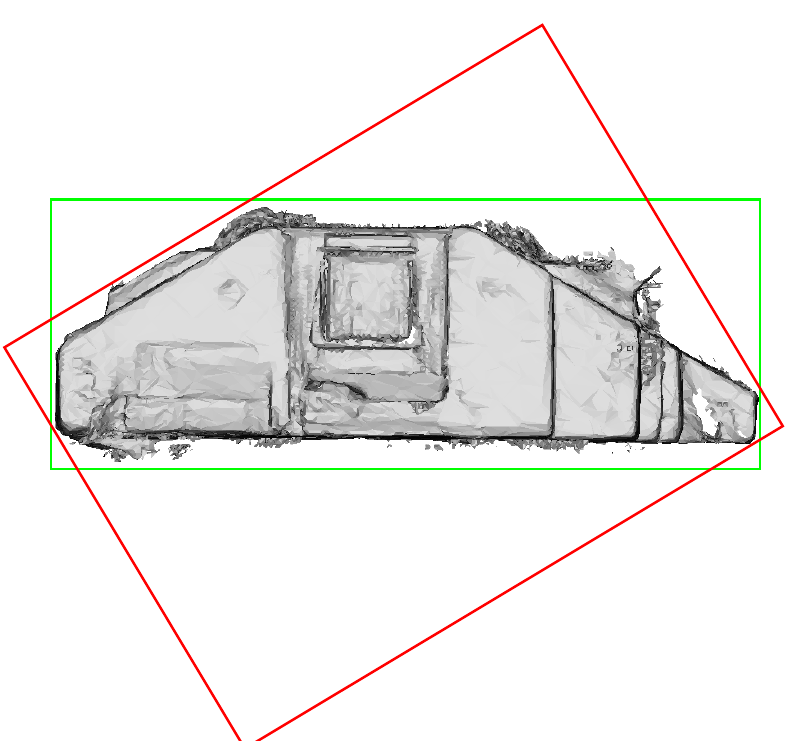
Figure 17. Resulting vertical alignments of the triangle mesh “Attic” from Figure 12c for the two peaks in the histogram of δ v values depicted in Figure 16. The green bounding box corresponds to the peak at δ v ≈ 0° (i.e., the ground truth pose), while the red bounding box corresponds to the minor peak at δ v ≈